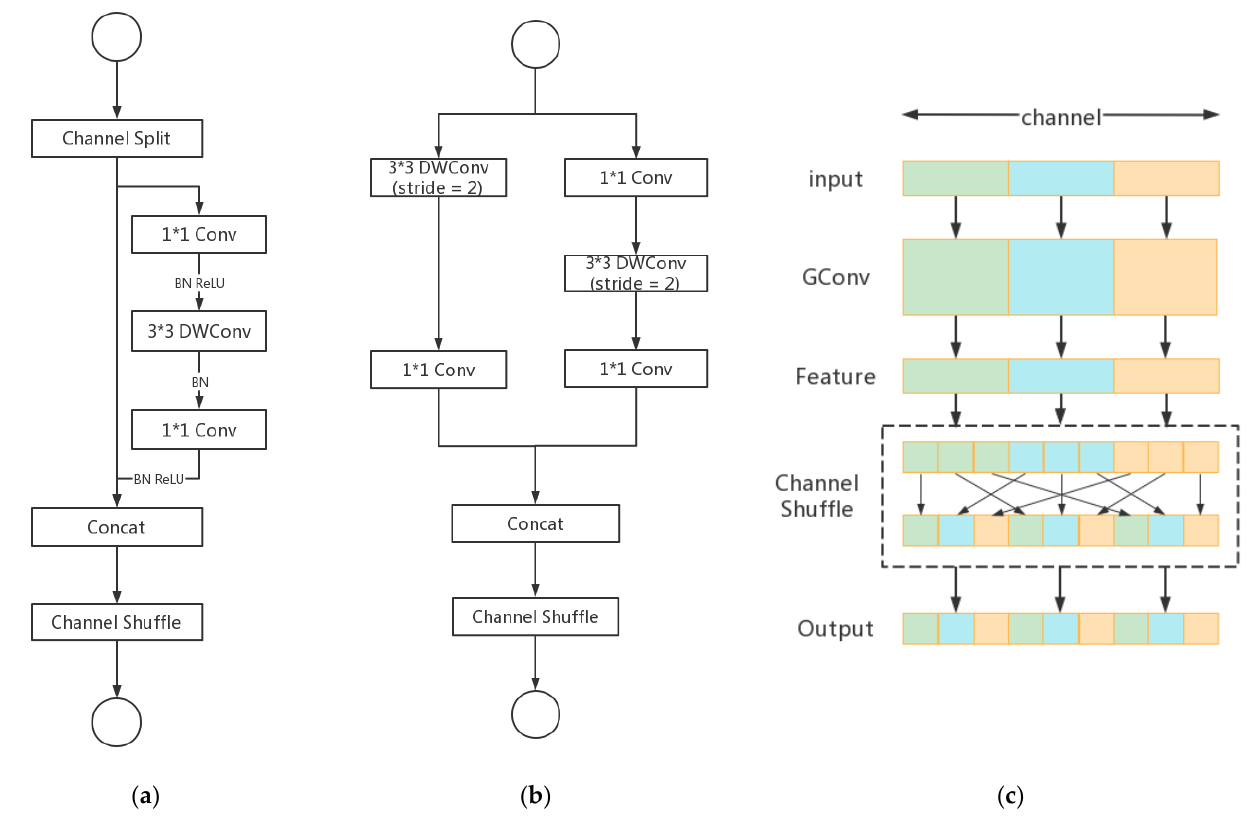
Figure 5. ( a ) ShuffleNetv2 unit1. ( b ) ShuffleNetv2 unit2. ( c ) Channel shuffle. The loss function of S-YOLOv5 consists of classification loss, localization loss, and confidence loss. Loss = l cls + l obj + l box . (1) BCE (binary cross-entropy) is used in the classification loss function, and I object deter- ij termines whether it is a positive sample; its value is either 0 or 1.